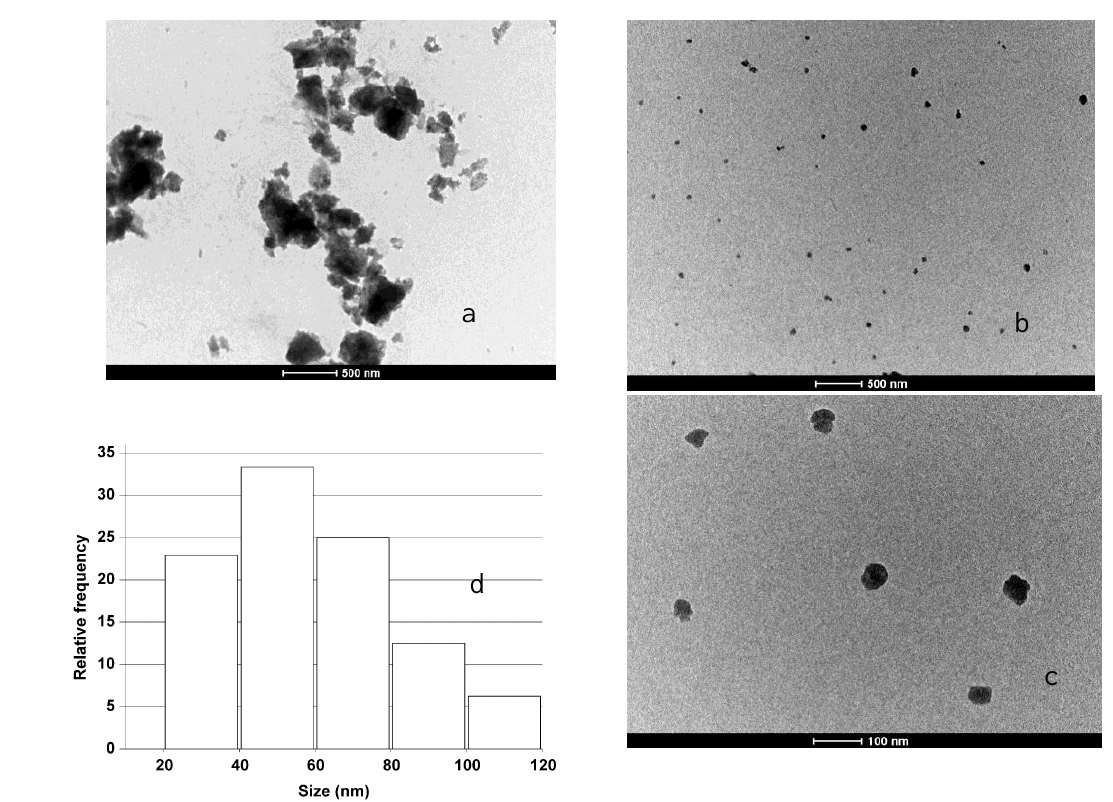
Figure 5. TEM images of the porous samples: ( a ) sample milled 2 h; ( b ) sample after sonication; ( c ) zoomed image of some particles, ( d ) particles size distribution of porous sample milled 2